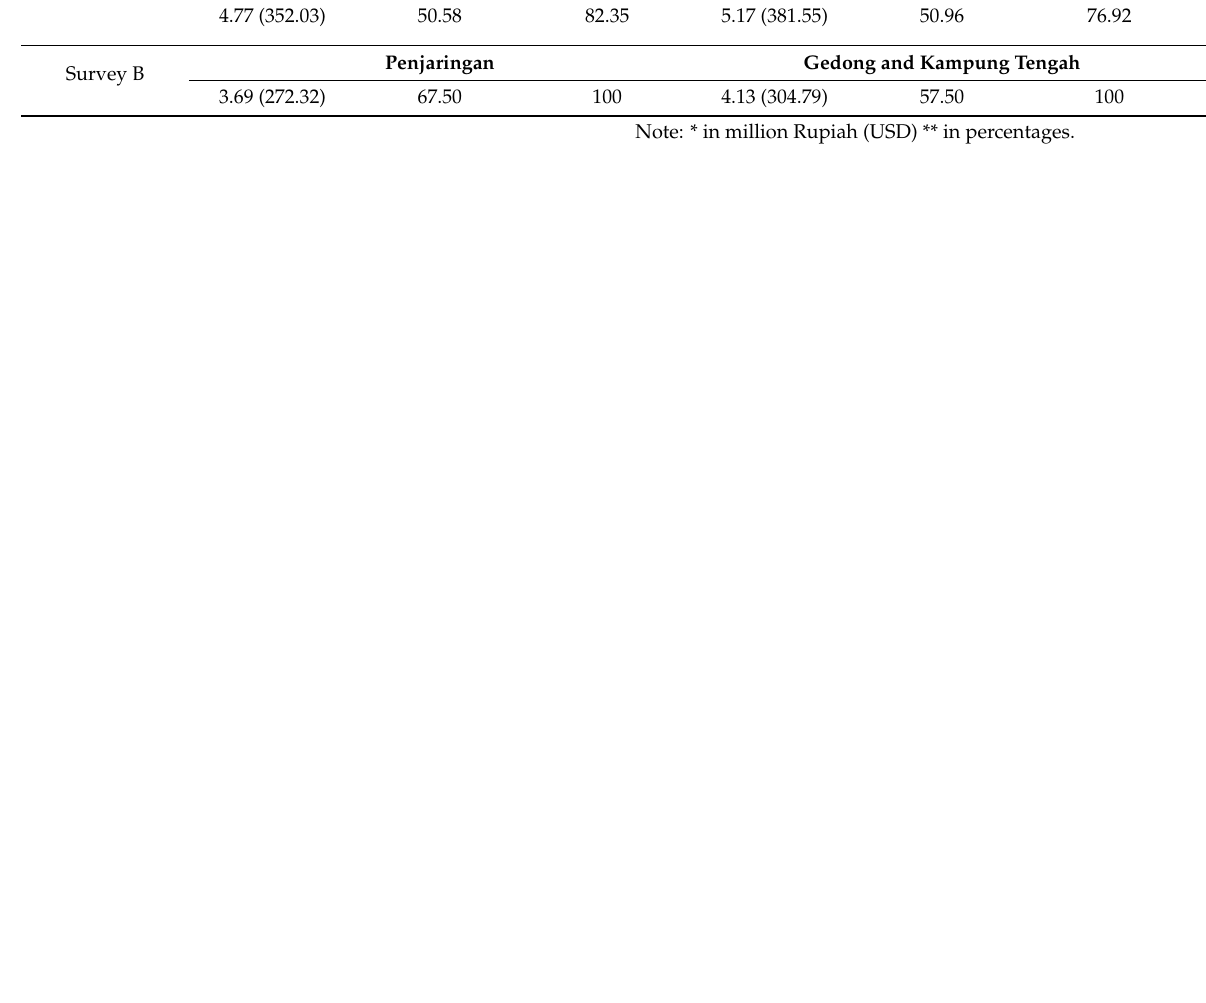
Share of Households below poverty Line **